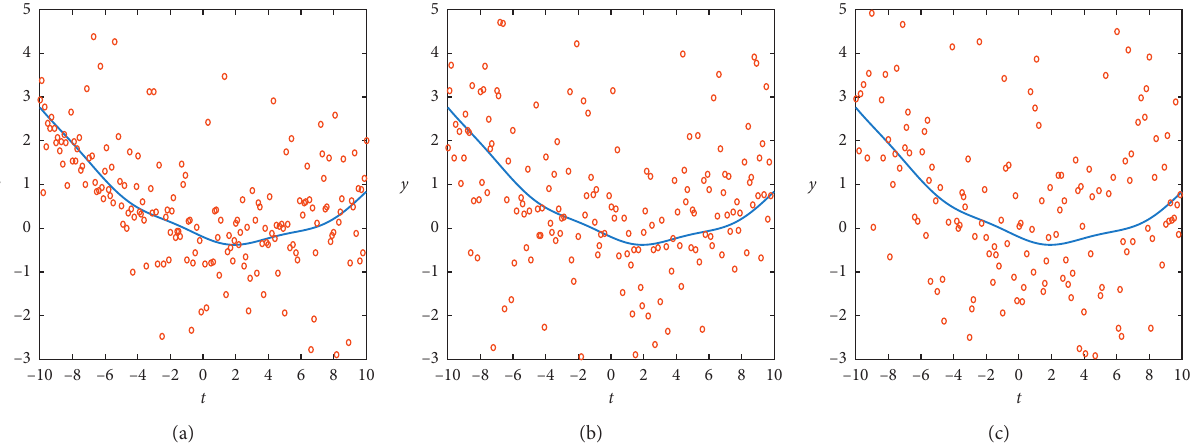
Figure 3: Generated signals with different noise strengths. The curves denote f ( t ; θ ) . The circles denote y ( t ) . (a) x � 0, c � 1.5. c � 1. (c) x 0